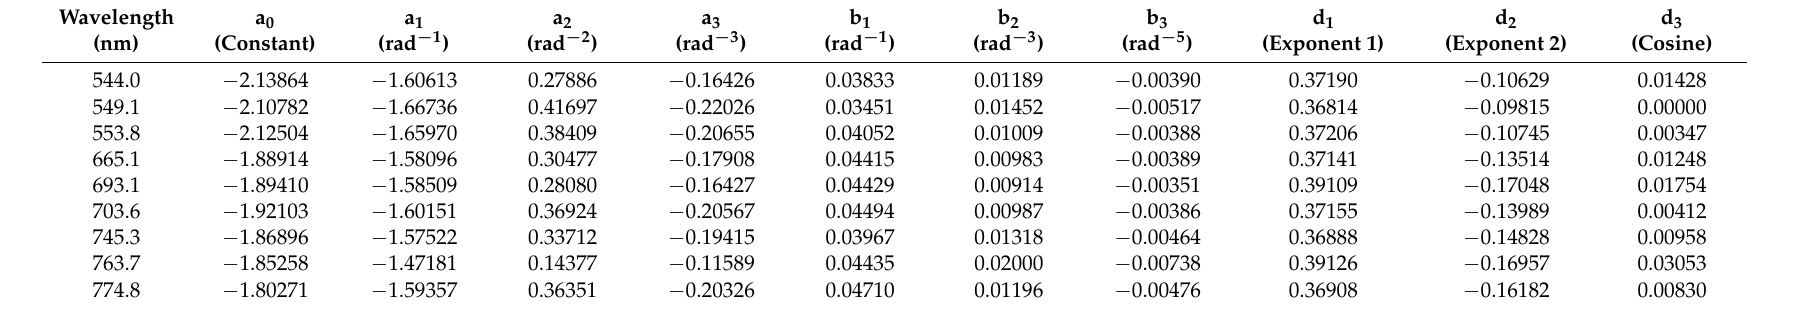
Table A3. ROLO Lunar Irradiance Model Coefficients